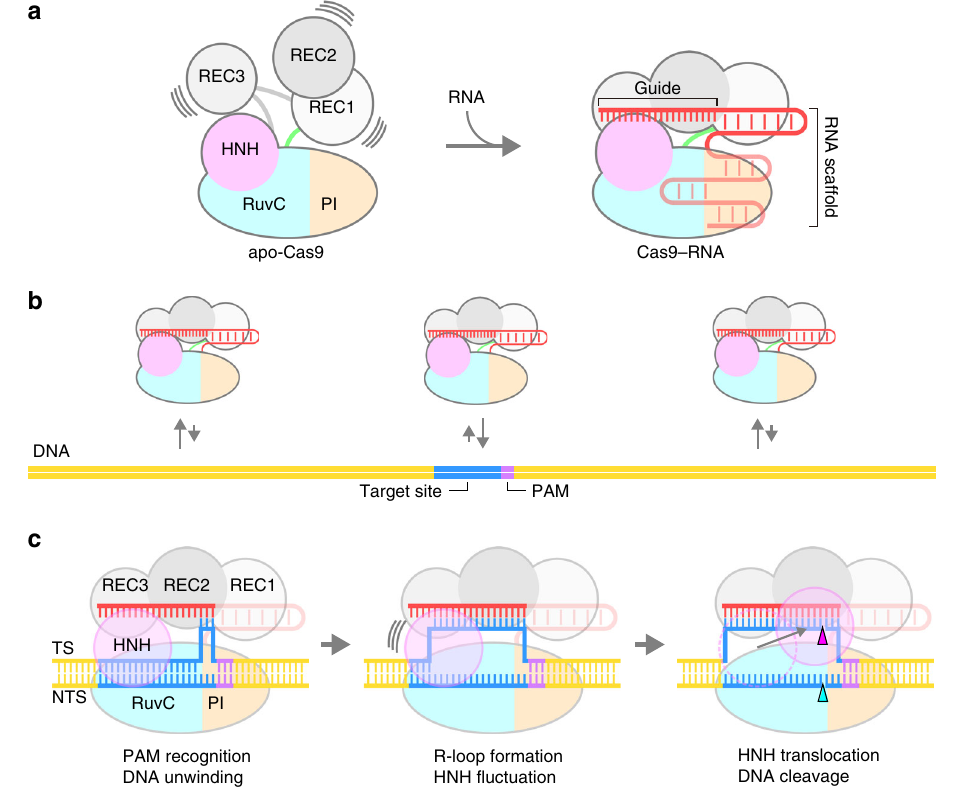
Fig. 7 Model of CRISPR-Cas9 action. a Assembly of the Cas9 – RNA binary complex. b Target DNA interrogation by Cas9 – RNA via three-dimensional diffusion. c DNA recognition and cleavage by Cas9 – RNA. DNA cleavages by the RuvC and HNH domains are indicated by the cyan and magenta triangles,